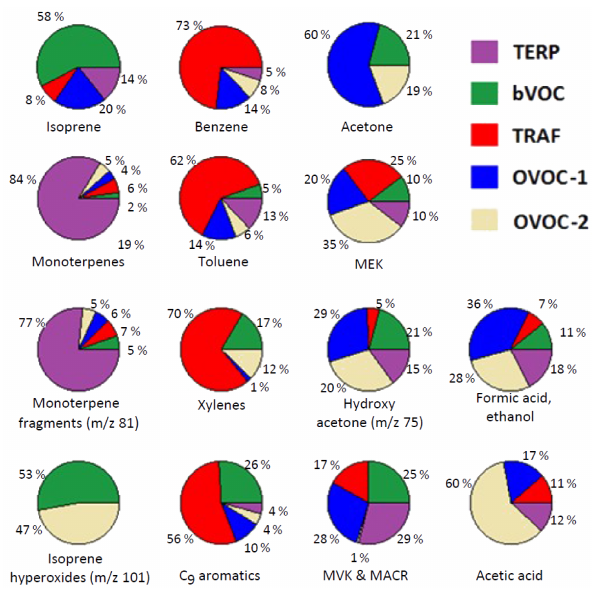
Figure 9. Species percentage (%) attributed to the PMF factors for the Athens summer